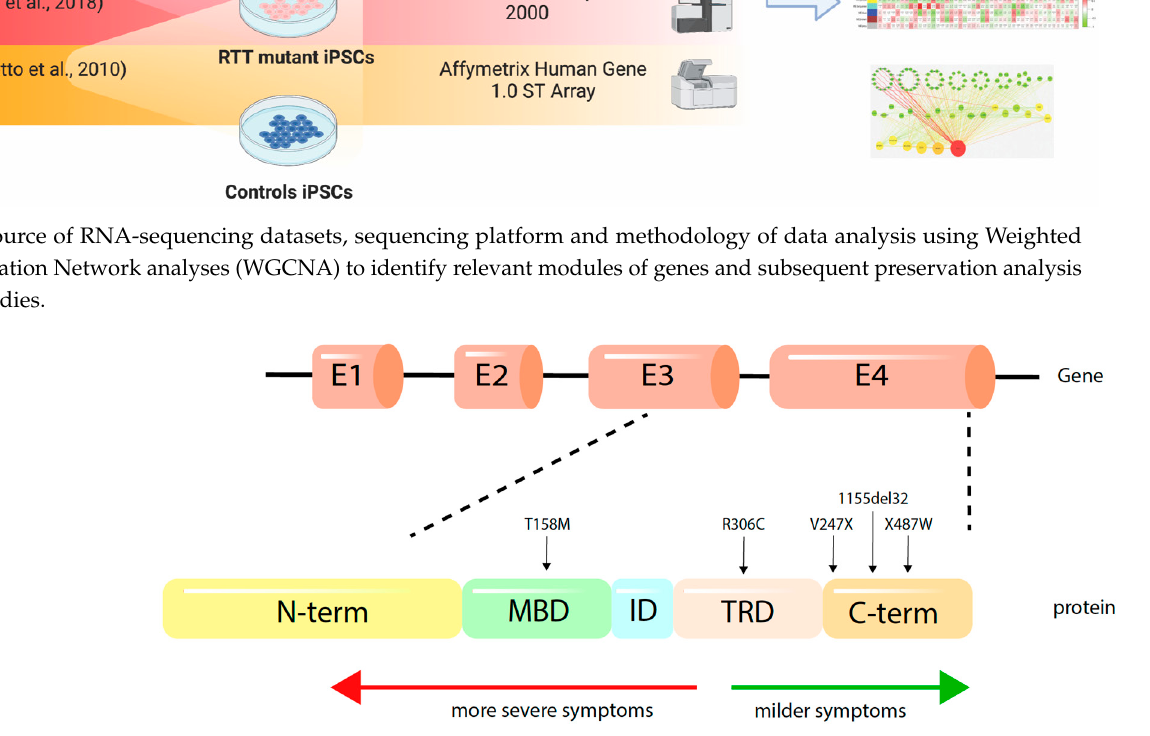
Figure 2. MECP2 gene and MeCP2 functional domains. Mutations covered in the present analysis are indicated by arrows. There are over 500 pathogenic mutations in MECP2, with the majority lying in exons 3 and 4 in the methyl binding domain (MBD), transcriptional repressor domain (TRD) and the C-terminal functional domain (CTD) regions, disrupting the normal function of the MeCP2 pro- tein.